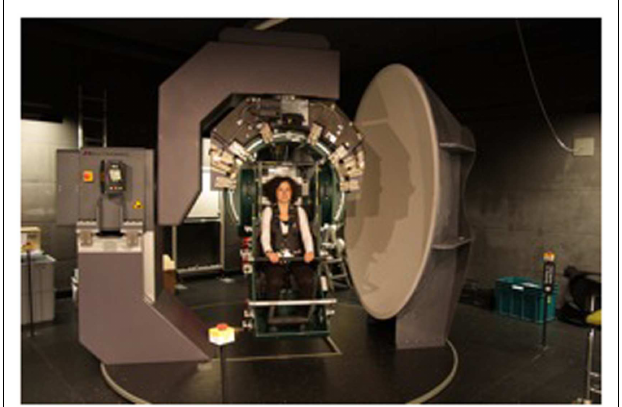
FIGURE 1 |The 3-D-Turntable . A 3-D-Turntable is a mechanical device, which operates as a three-axis stimulator. It can be driven into any position in space and turn in any angle desired up to